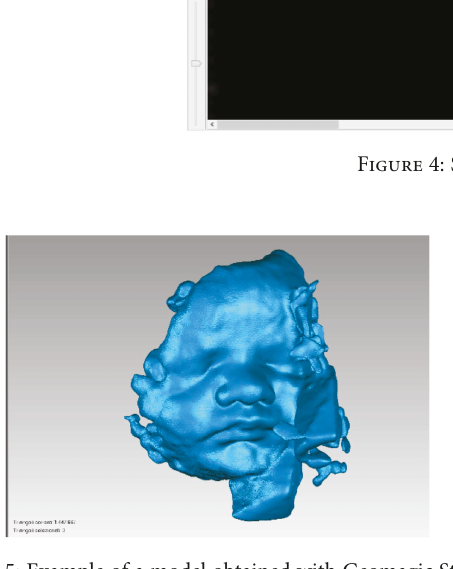
Figure 5: Example of a model obtained with Geomagic